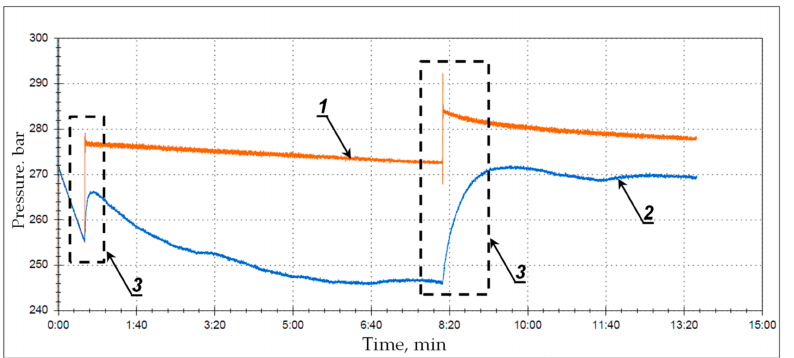
Figure 13. Testing of the prop along with the double block with pressure boost, where 1—boost pressure in the block, 2—pressure in the sub-piston space of the prop, and 3—automatic pressure charging.